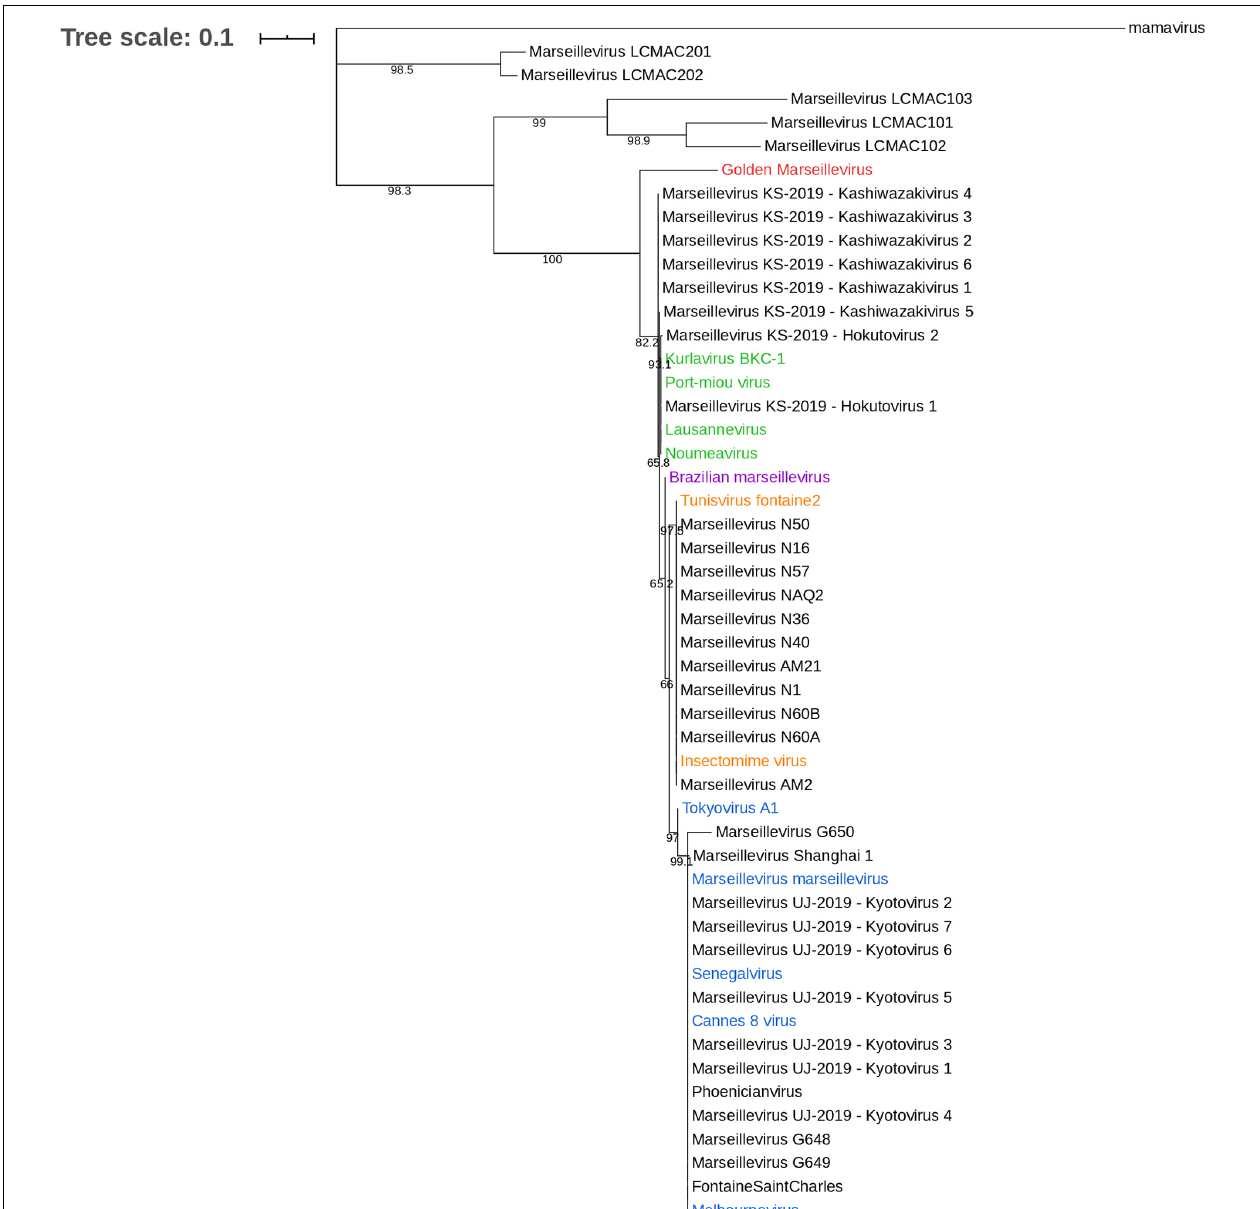
FIGURE 5 | Phylogenetic tree based on the major capsid protein (MCP). The analysis was performed using the Maximum Likelihood method (ML) with a JTT substitution matrix and 1,000 replicates. MCP sequences of marseilleviruses are color-labeled according to their classification into lineages: blue corresponds to lineage A, green to lineage B, orange to lineage C, purple to lineage D, and red to lineage E.